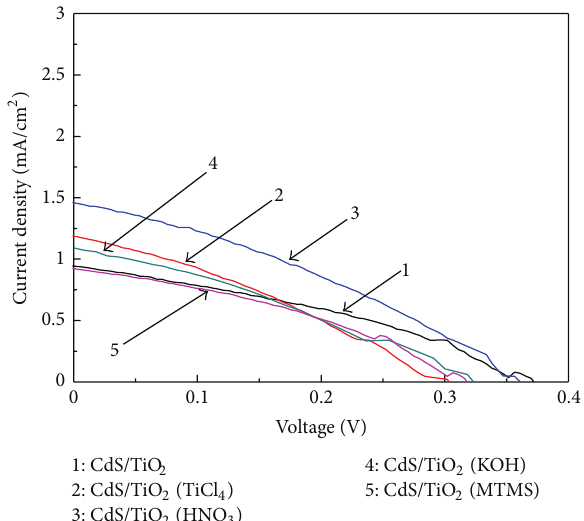
Figure 6: 𝐽 - 𝑉 curves of CdS-sensitized solar cells with different modifications. Table 1: Photovoltaic parameters of QDSSCs with different modifi- cations.